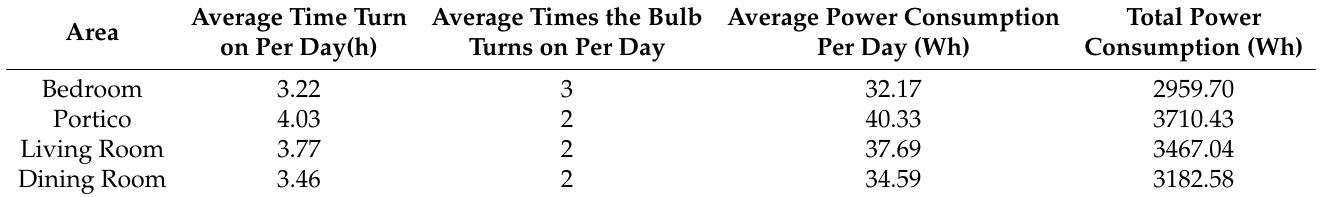
Figure 8. e-Switches home distribution. Table 4. Power consumption calculated based on register container.